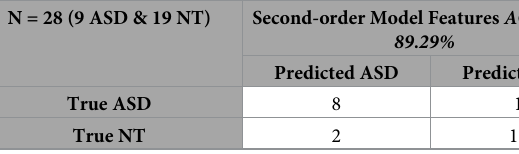
Table 5. Cross validation confusion